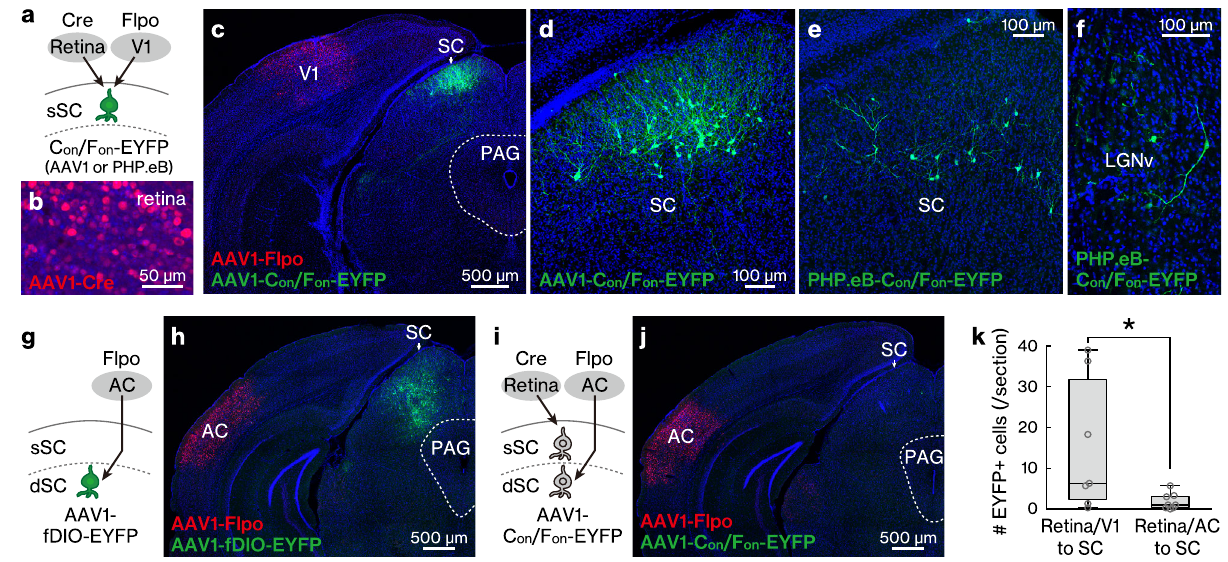
Fig. 3 Intersectional, anterograde transsynaptic labelling of the retina/V1 to sSC pathway. a – f Intersectional, anterograde transsynaptic labelling of the retina/V1 to SC pathway. a Schematic of the experiment. b Representative Cre (red) expression in the retina infected with AAV1-Cre. b – f , h , j Blue, DAPI. c , d Coronal sections showing the Flpo expression ( c , red) in the V1 and the EYFP (green)-positive cells in the SC ( c , d ). The AAV1 containing C on /F on -EYFP expression cassette was injected locally in the SC. N = 7 mice. d Magni fi ed view of ( c ). e , f Coronal sections showing the EYFP (green)-positive cells in the left SC (7.0 ± 9.0 cells/section) ( e ) and left LGNv (1.8 ± 1.7 cells/section) ( f ). The C on /F on -EYFP expression cassette was delivered to the whole brain by the retroorbital injection of PHP.eB. N = 4 mice. g , h Anterograde transsynaptic labelling of the AC to deep SC (dSC) pathway. g Schematic of the experiment. h Coronal section showing the EYFP (green) expression in the deep SC following the AAV1-Flpo (red) and AAV1-fDIO-EYFP injections into the AC and SC, respectively. N = 8 mice. i , j Lack of intersectional, anterograde transsynaptic labelling for the retina/AC to SC pathways. i Schematic of the experiment. j Coronal section showing few EYFP (green)-positive cells in the SC following AAV1-Cre, AAV1-Flpo (red), and AAV1-C on /F on -EYFP injections into the retina, AC, and SC, respectively. N = 8 mice. k Numbers of EYFP-positive cells in the SC for the retina/V1 to SC ( c , d ) and retina/AC to SC ( j ) pathway experiments. N = 7 (retina/V1 to SC) and 8 (retina/AC to SC) mice. * P = 0.029, Mann – Whitney U test. Center line, median; box limits, upper and lower quartiles; whiskers, min and max. sSC super fi cial superior colliculus, V1 primary visual cortex, LGNv ventral lateral geniculate nucleus, EYFP enhanced yellow fl uorescent protein, AC auditory cortex, AAV1 adeno-associated virus serotype